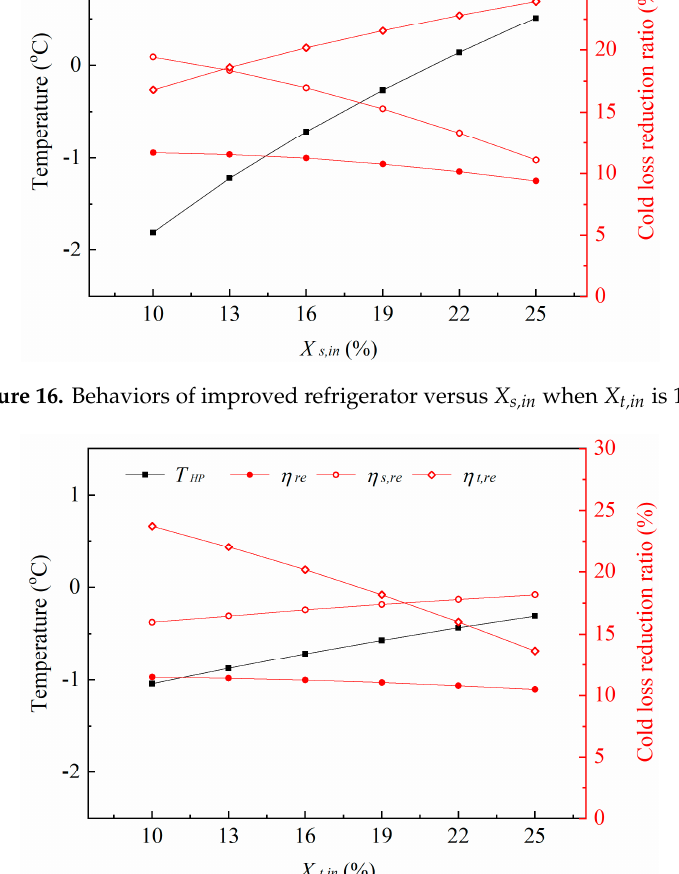
Figure 17. Behaviors of improved refrigerator versus X t,in when X s,in is 16%.